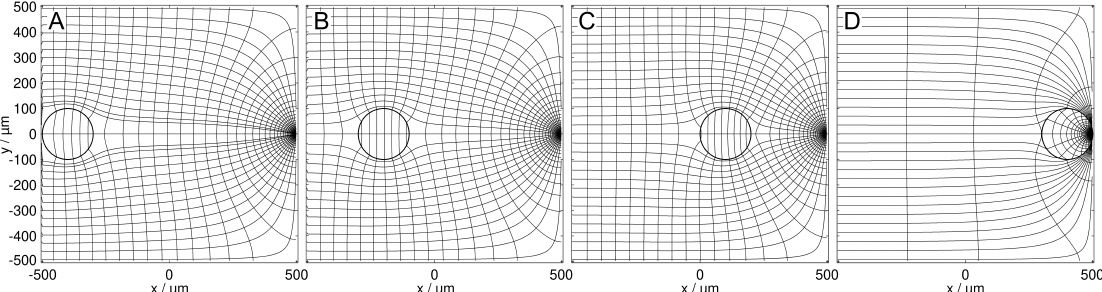
Figure 4. Potential and current line distributions for different positions of the 0.1 S sphere in the 1.0 S medium, at the plain electrode ( A ), in a largely homogeneous field region ( B , C ), and in front of the pointed electrode ( D ). The conductances are ( A ): 343.29 mS, ( B ): 342.28 mS, ( C ): 340.10 mS, and ( D ): 60.682 mS. The basic sheet conductance L 2 D of 348.97 mS without sphere corresponds to a cell Basic constant of k 2 D =